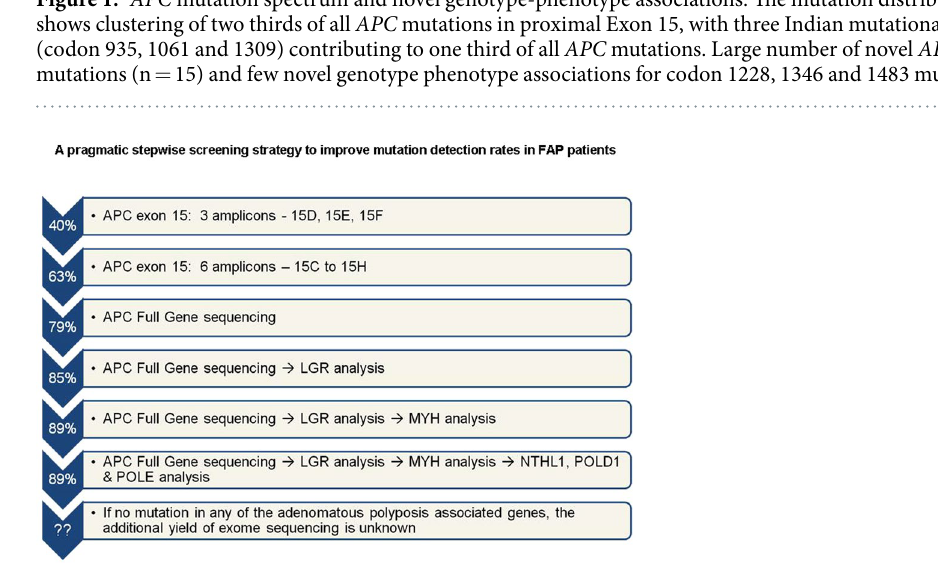
Figure 2. A pragmatic stepwise screening strategy to improve mutation detection rates in FAP patients. Cumulative mutation detection rates with step wise screening of exons/genes most likely to be mutated in south Asian FAP cases. Arrows on left side shows the cumulative mutation detection rates in our cohort achieved after each step. In our cohort, the cumulative mutation detection rate did not change with NTHL1 , POLD1 and POLE gene analysis it may increase the detection rate slightly in larger cohorts of APC and MUTYH negative adenomatous polyposis cases from different geo-ethnic